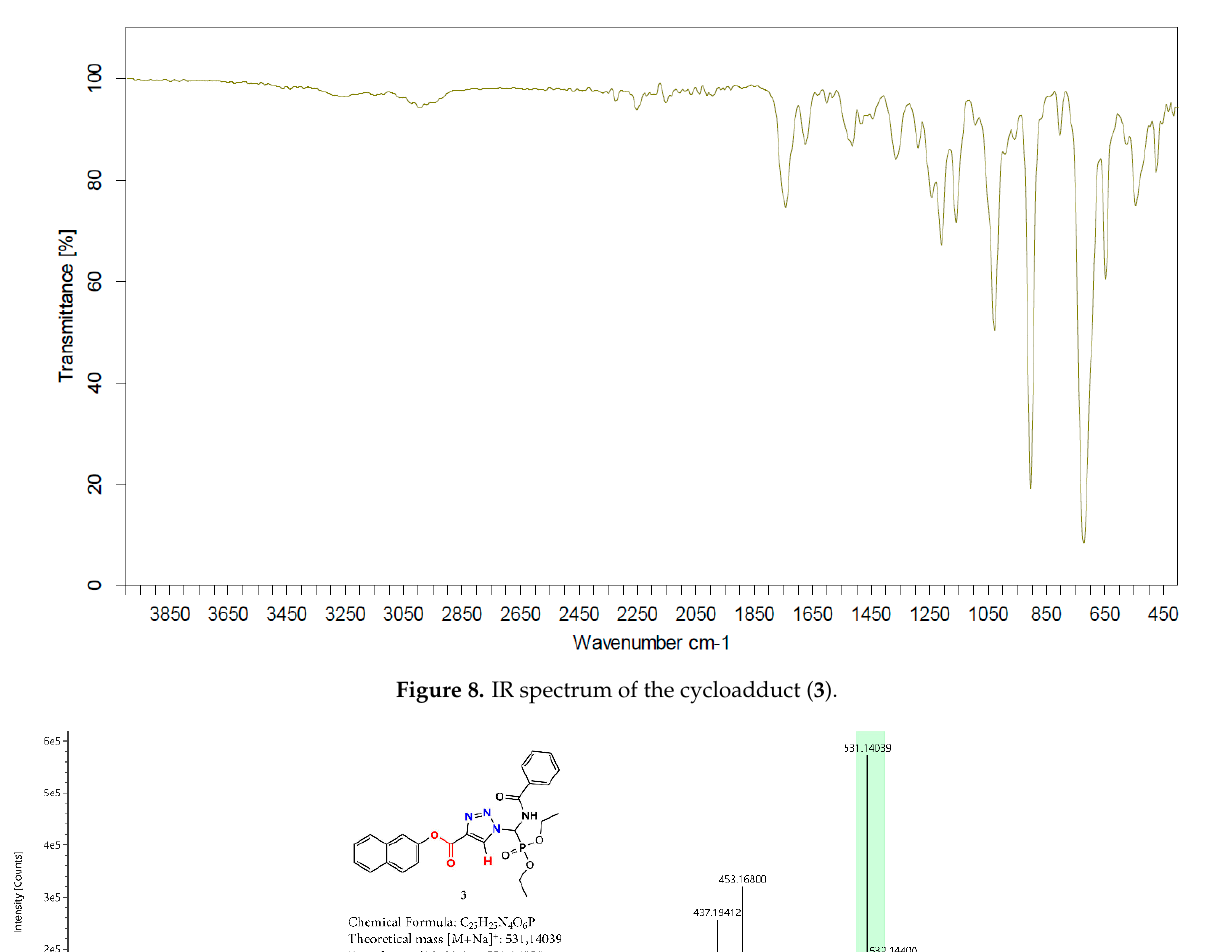
Figure 9. HRMS spectrum of the cycloadduct ( 3 ).